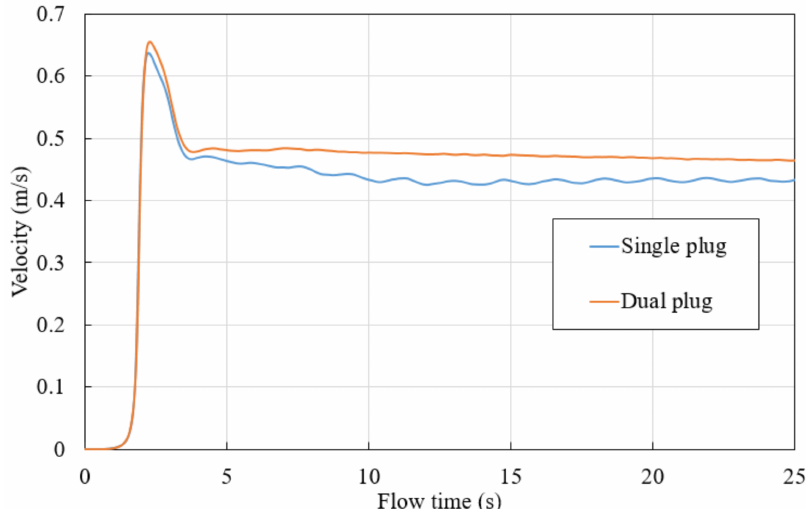
Figure 9. Flow velocities for single- and dual-plug ladles.